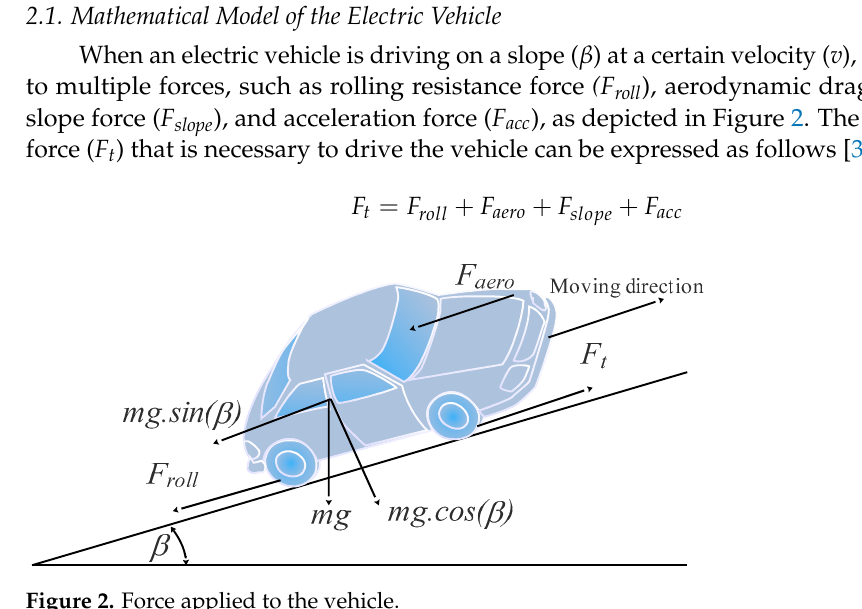
Figure 1. Electric vehicle con fi guration.